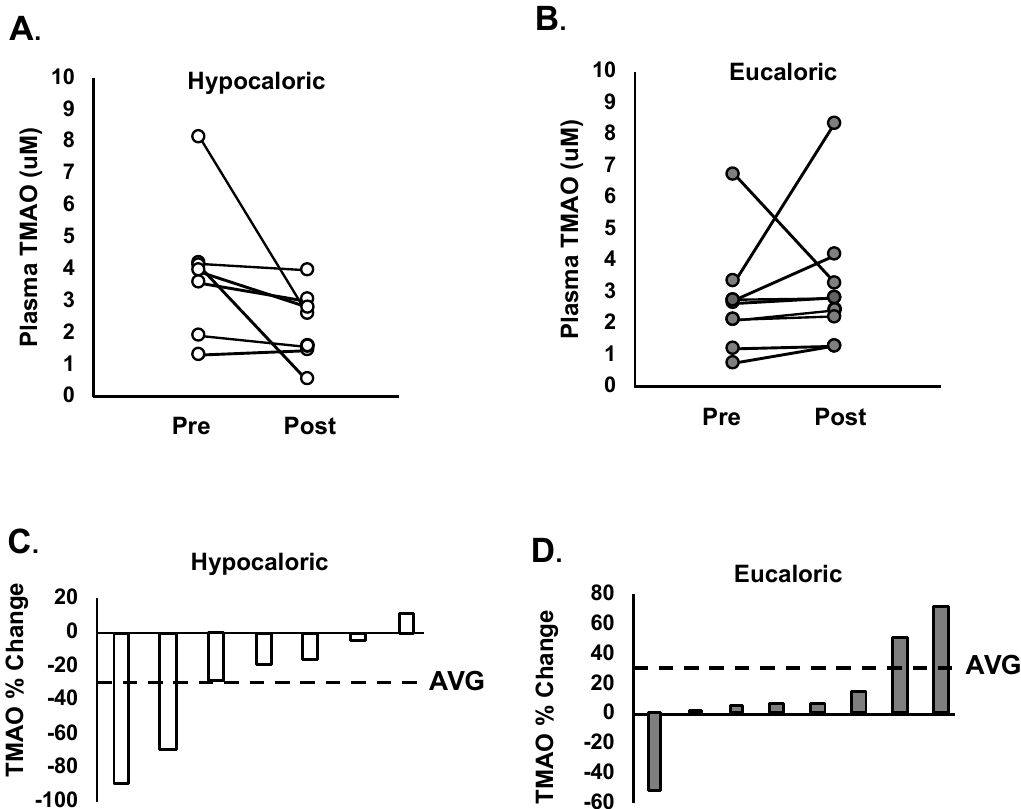
Figure 1. ( A ) Individual changes in plasma TMAO (trimethylamine N-oxide) concentrations before and after 12 weeks of a hypocaloric diet combined with supervised exercise. ( B ) Individual changes in plasma TMAO concentrations before and after 12 weeks of a eucaloric diet combined with supervised exercise. ( C ) Individual percent change in plasma TMAO concentrations after 12 weeks of a hypocaloric diet combined with supervised exercise. Group average denoted by a horizontal dashed line. ( D ) Individual percent change in plasma TMAO concentrations after 12 weeks of a eucaloric diet combined with supervised exercise. Group average denoted by a horizontal dashed line.